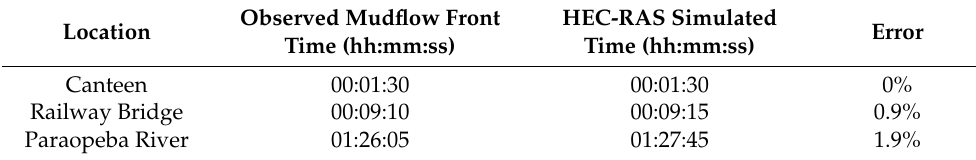
Figure 5. Simulated depth hydrographs at the arrival control points, plotted with the observed arrival times. Table 4. Timing of observed and simulated mudflow front.